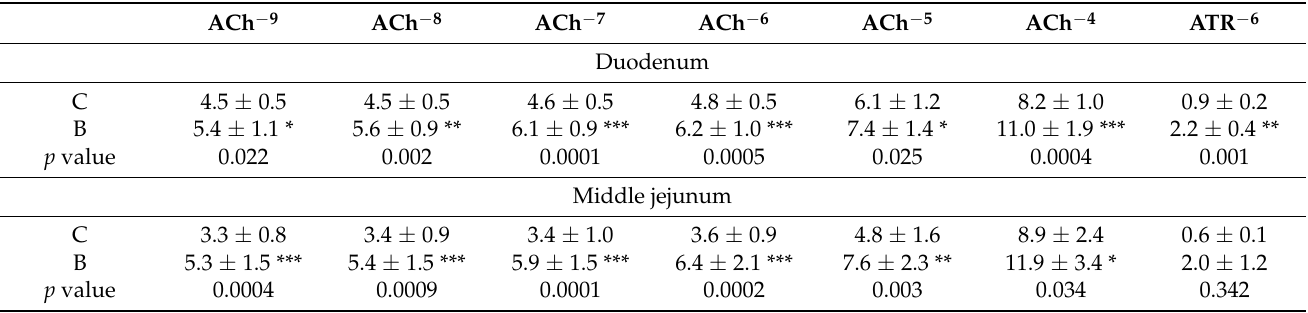
Table 2. Amplitude of contractions (mm) of acetylcholine (ACh)-stimulated or atropine-treated duodenal and middle jejunum fragments in control (C) and sodium-butyrate-treated piglets (B) at a dose of 0.3% on day 10 of life. Values are given as means ± SD; * indicates statistical differences between groups when * p < 0.05, ** p < 0.01, *** p < 0.001.